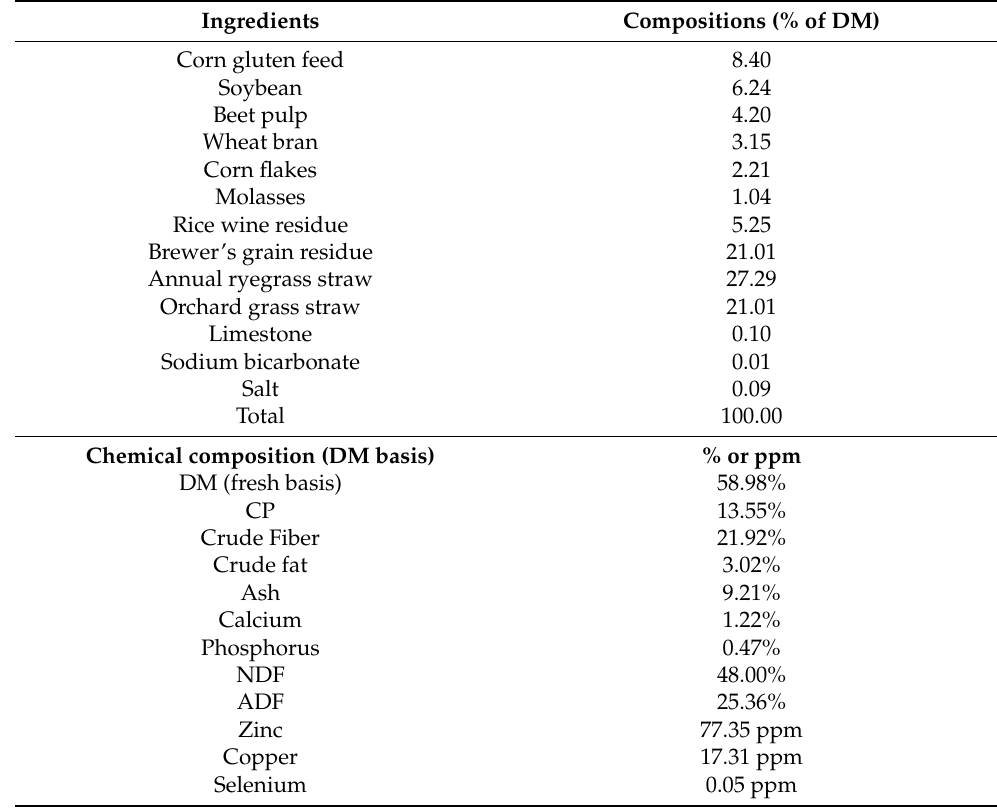
Table 1. Chemical composition of total mixed ration